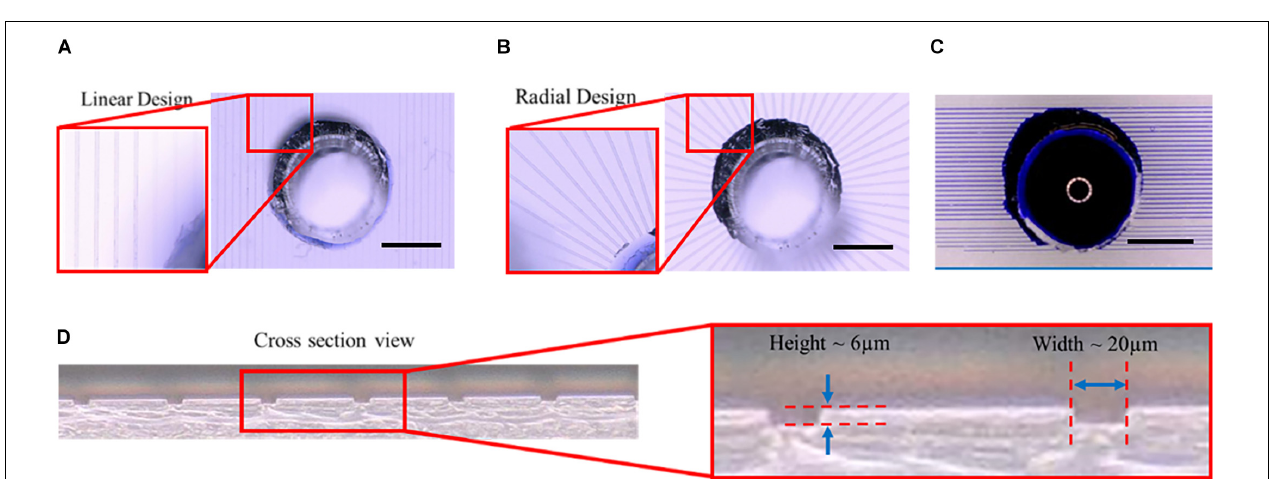
FIGURE 3 | Microtunnel devices with linear and radial configuration. (A) Microtunnel device made of polydimethylsiloxane (PDMS) with microtunnels in a linear configuration, i.e., tunnels in parallel with inlets punched through the PDMS to access the tunnels. (B) Microtunnel device made of polydimethylsiloxane (PDMS) with microtunnels in a radial configuration, with a center inlet from which the tunnels extend outwards. (C) An example of a leakage test for the linear microtunnel configuration using a water-soluble dye. The dye was place on the inlet to check for any leakage points, showing proper bonding between the PDMS components of the device. Scale bars in (A–C) denote 1 mm. (D) A cross-section was cut of a microtunnel device to verify the dimensions of the microtunnels, showing a height of 6 µ m and a width of 20 µ m for the example shown.